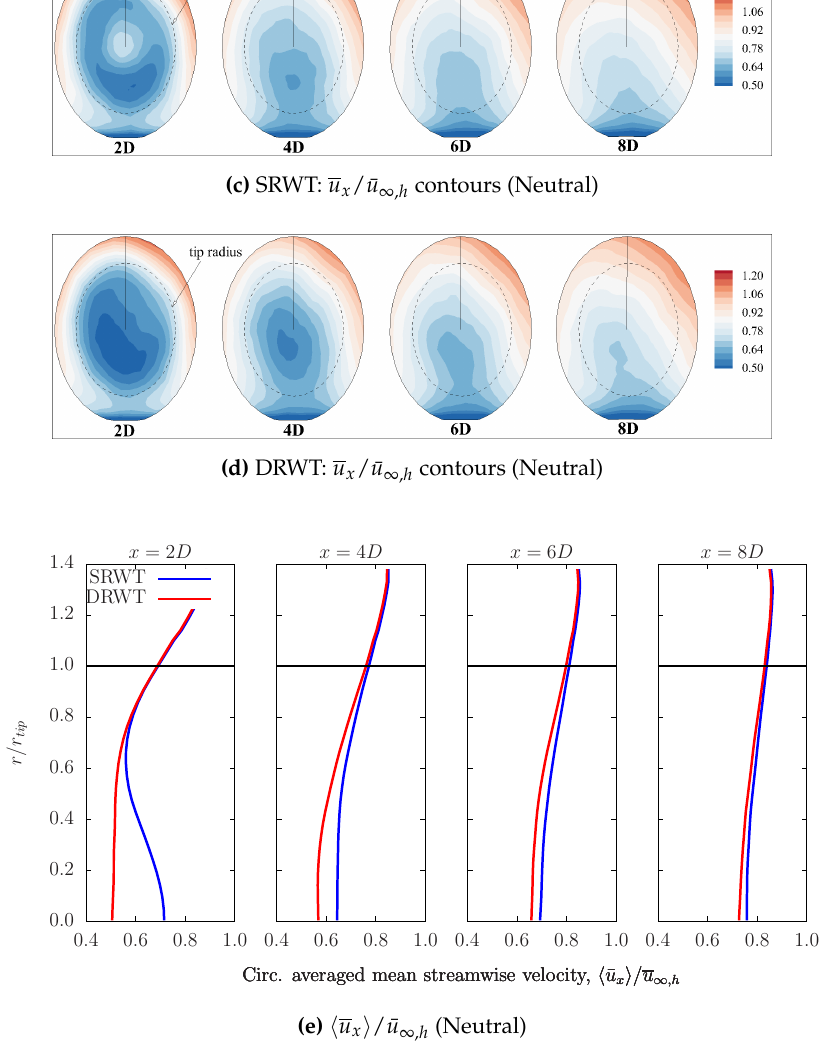
Figure 10. Comparison between SRWT and DRWT of normalized mean streamwise velocity, u x / u ∞ , h : ( a , b ) on the x - z plane passing through the rotor hub; ( c , d ) on cross-stream ( y - z ) planes; and ( e ) circumferentially averaged values at four downstream locations ( x / D = 2, 4, 6, and 8) for the neutral ABL